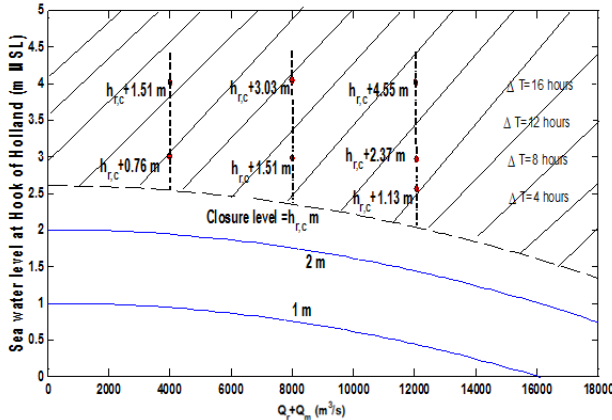
Figure A5. The closure decision making of the Maeslant Barrier.